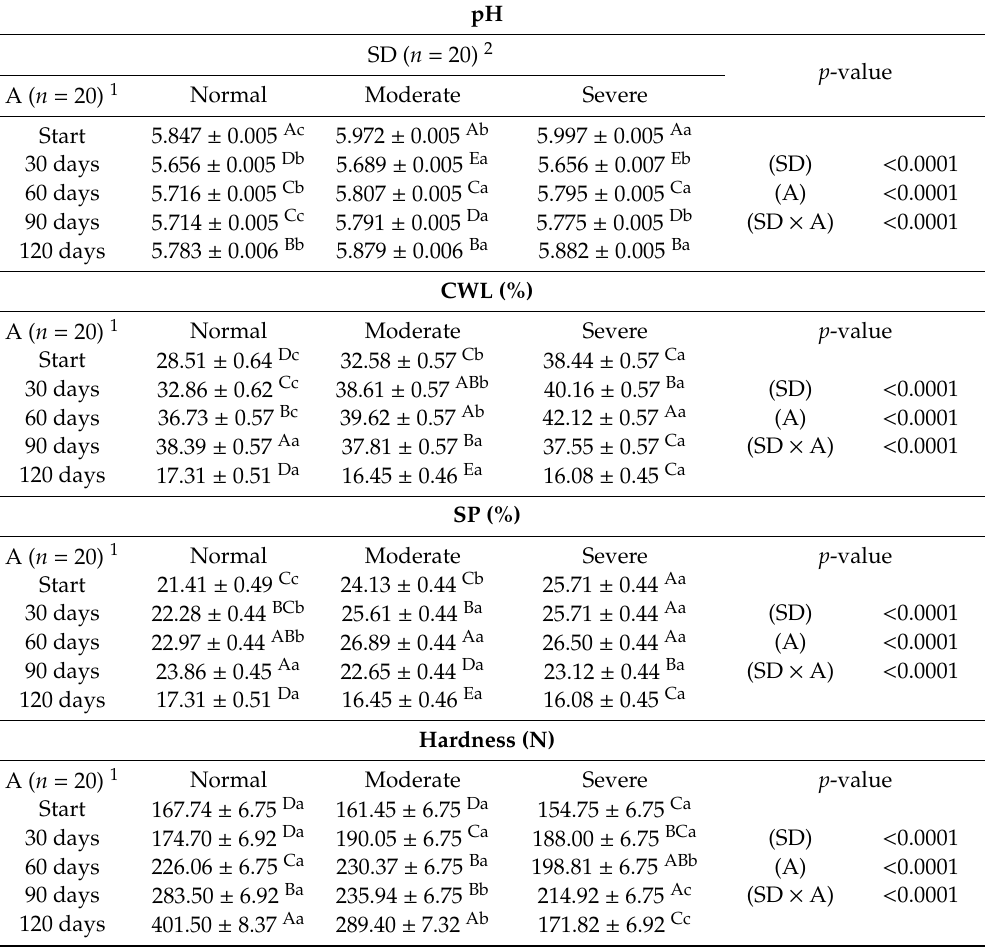
Table 3. Mean values of pH, cooking weight loss (CWL), shrinkage percentage (SP) and hardness of hamburgers produced from Ross broiler chicken (AP95) without myopathies and a ff ected by wooden breast myopathy after di ff erent storage